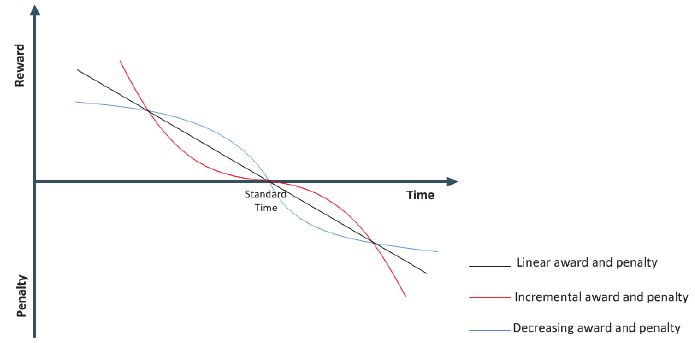
Fig. 2. Options of penalties and rewards according to the project